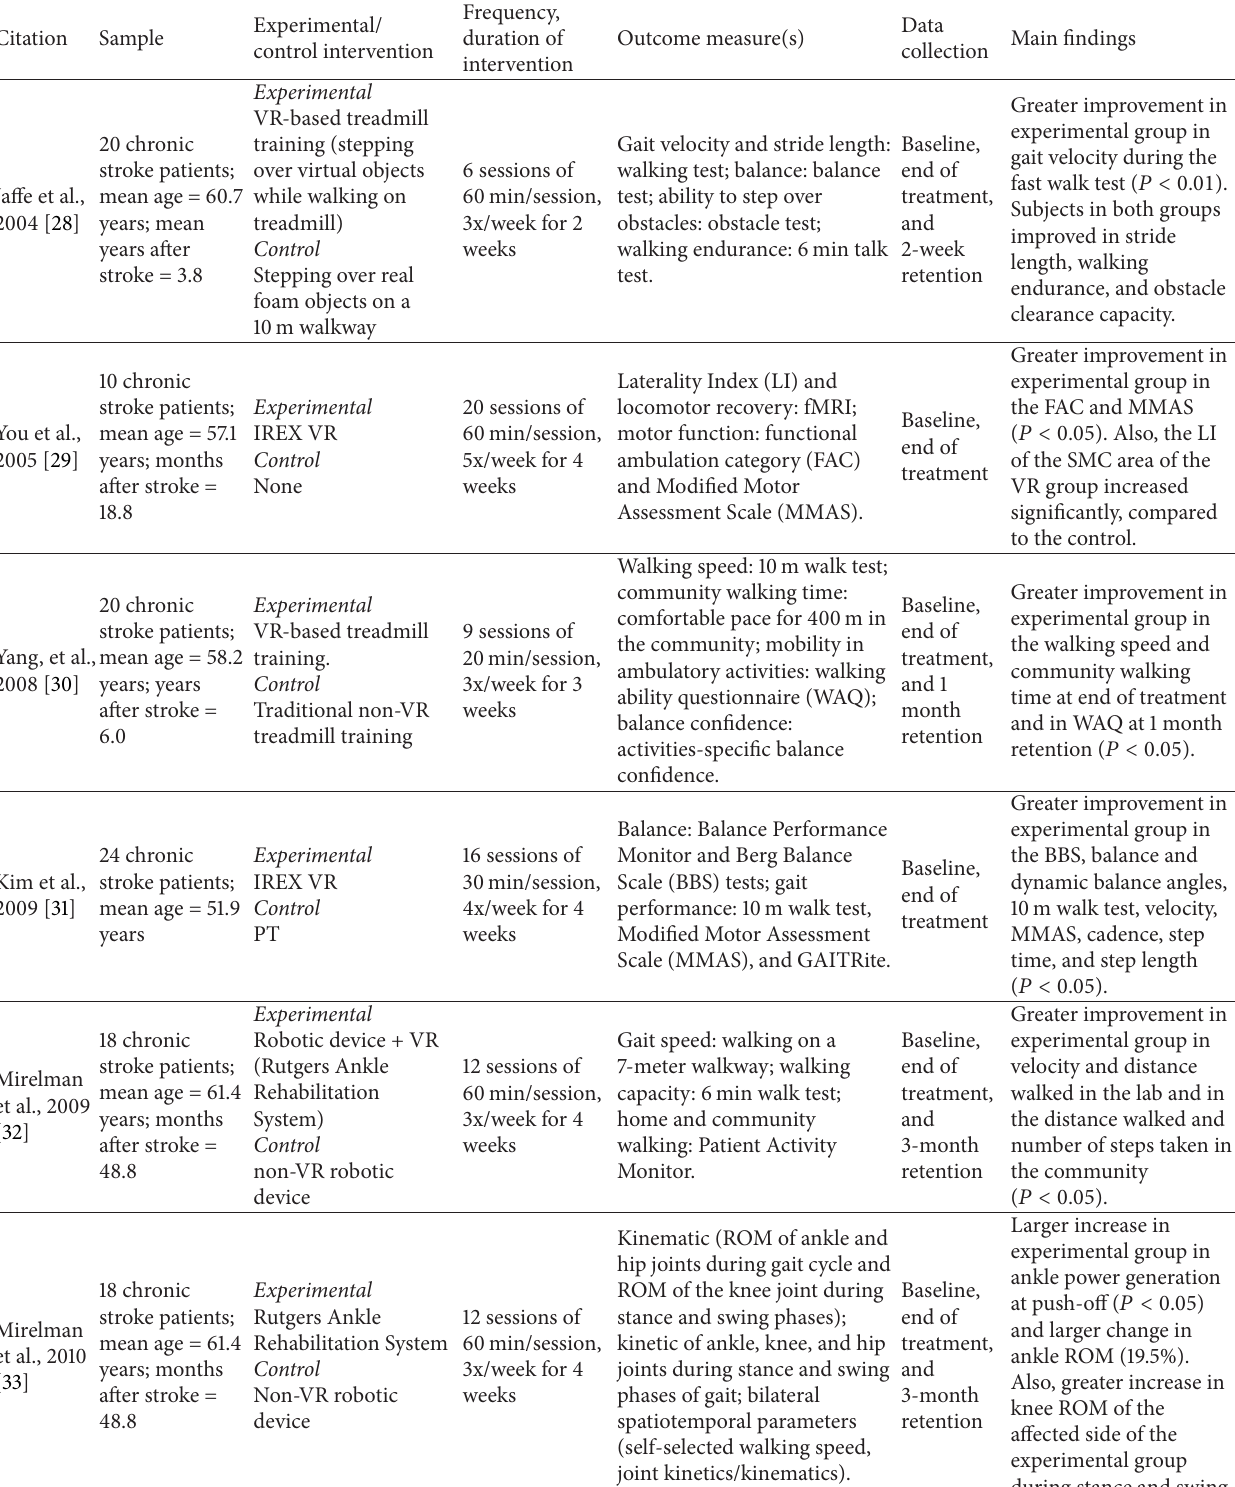
Table 1: Characteristics of the selected studies ( 𝑛 = 11